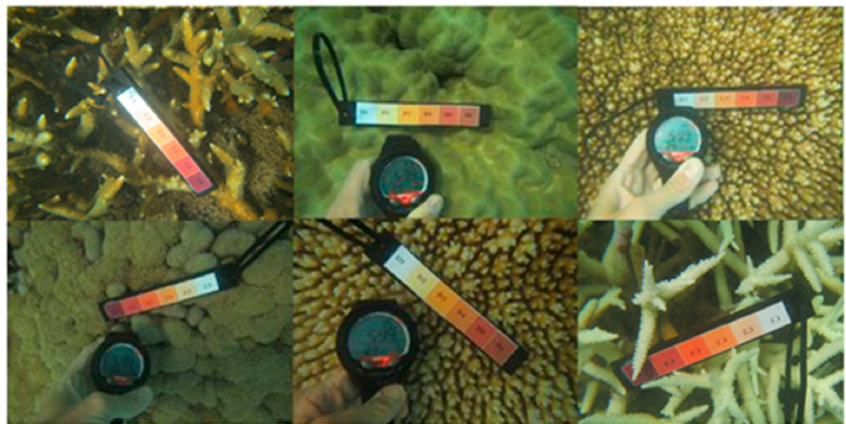
Figure 2. Example of in-water reference data with relevant bleaching level: 1 (severely bleached) to 6 (unbleached). Bleaching levels and genus from top left to bottom right: 5 Acropora , 4 Porites massive, 3 Acropora , 3 Goniopora , 2 Acropora , 1 Acropora . Courtesy of Sam Noonan (Australian Institute of Marine Science (AIMS)).